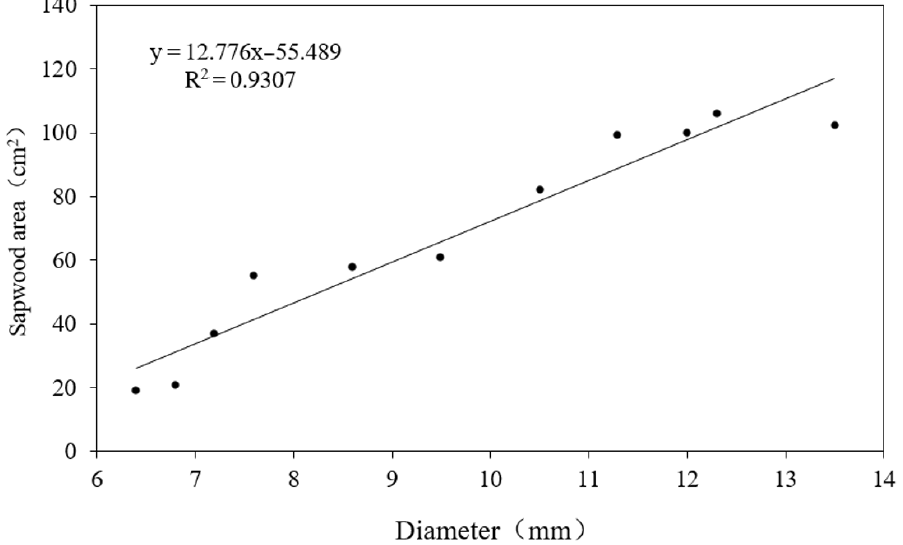
Figure 2. Relationship between diameter and sapwood area at the beginning of study in 2019.